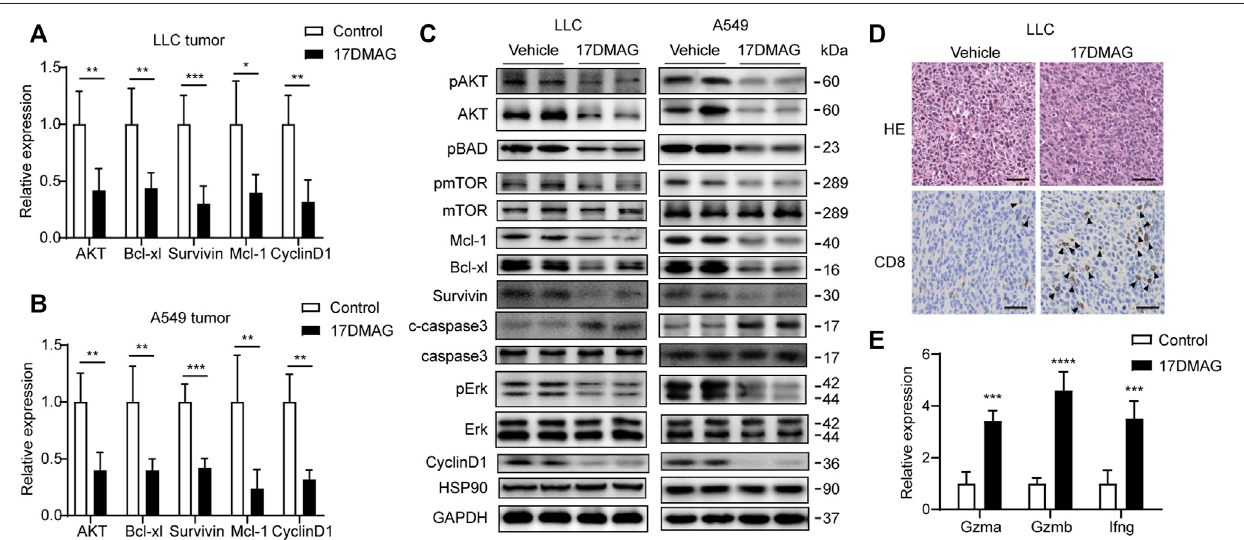
FIGURE 8 | Inhibiting HSP90 reversed AKT1/ERK activation in vivo . (A) mRNA levels of indicated genes from LLC tumor tissue were tested by qPCR. * p < 0.05, ** p < 0.01, *** p < 0.001. (B) mRNA levels of indicated genes from A549 tumor tissue were tested by qPCR. ** p < 0.01, *** p < 0.001. (C) Lysates from LLC and A549 tumor tissuewereanalyzed bywesternblottingand probed withindicated antibodies. (D) Representative imagesofLLC tumor sectionsstainedwithCD8antibody. The positive staining of CD8 wasmarked with arrows. Scale bar (cid:1) 50 μ m. (E) Expression of genes related to lymphocyte cytotoxicity. Relative mRNA expression levels were adjusted to the level of beta-actin mRNA for each sample. *** p < 0.001, **** p <